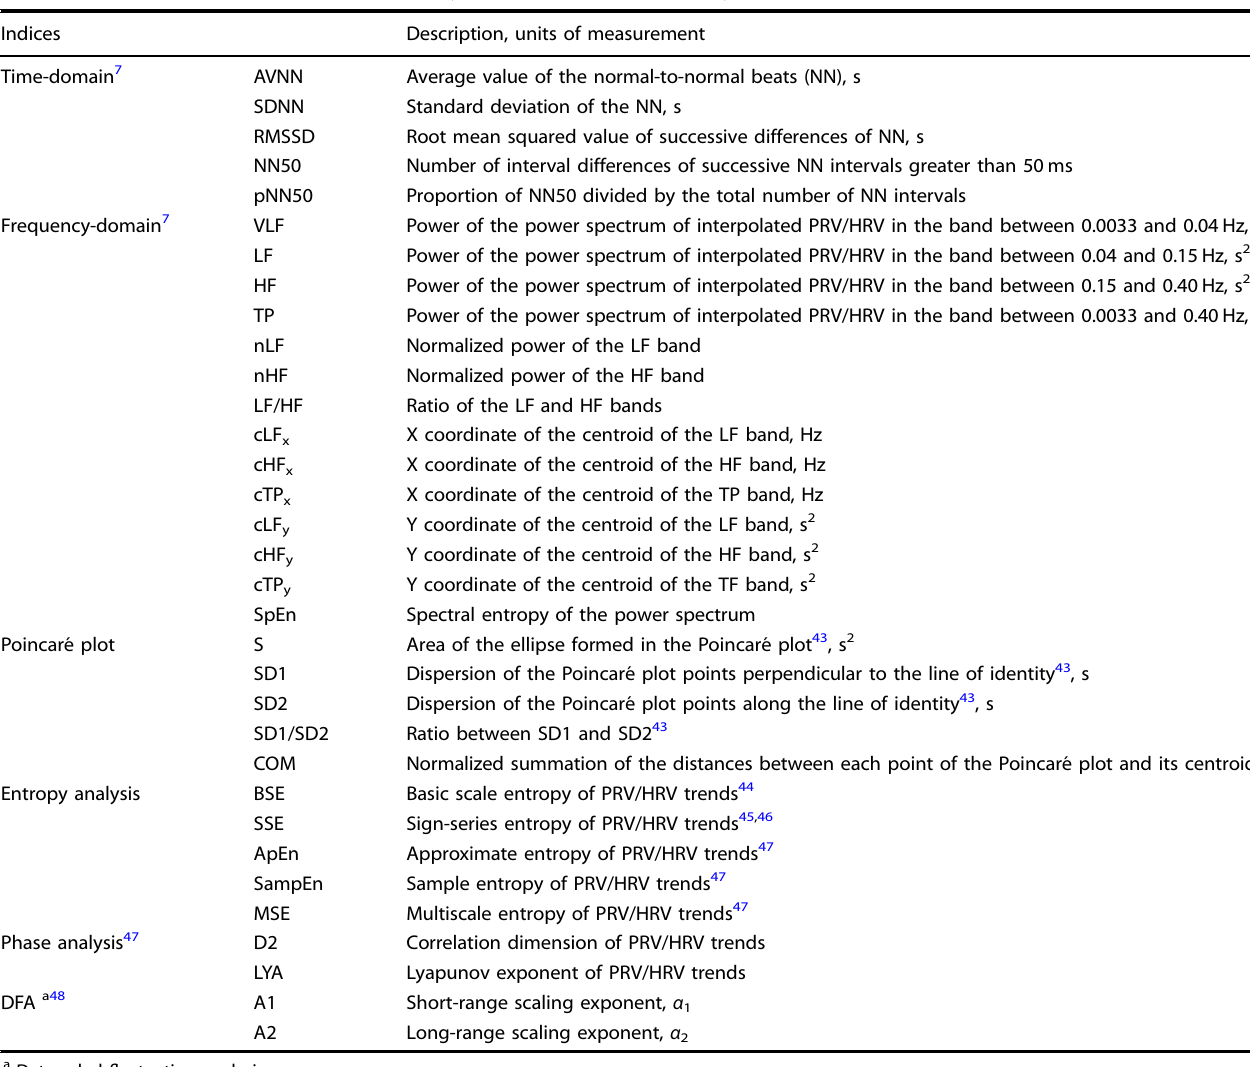
Table 1. Indices extracted from pulse rate variability (PRV) and heart rate variability (HRV).